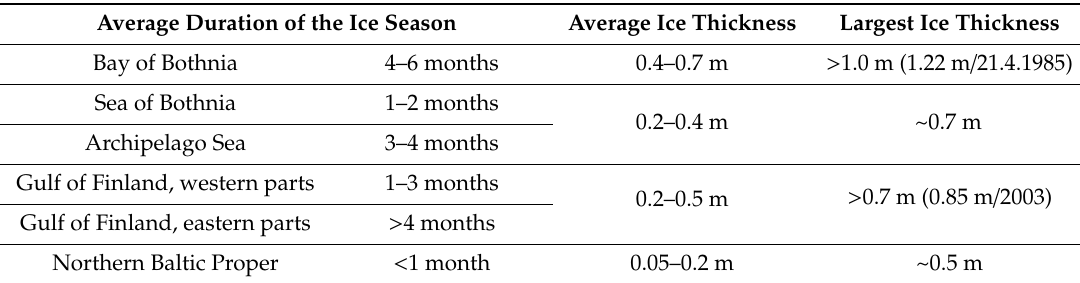
Table 1. Statistics on the Baltic Sea ice season duration and the thickness of the landfast ice. Compiled by the Finnish Ice